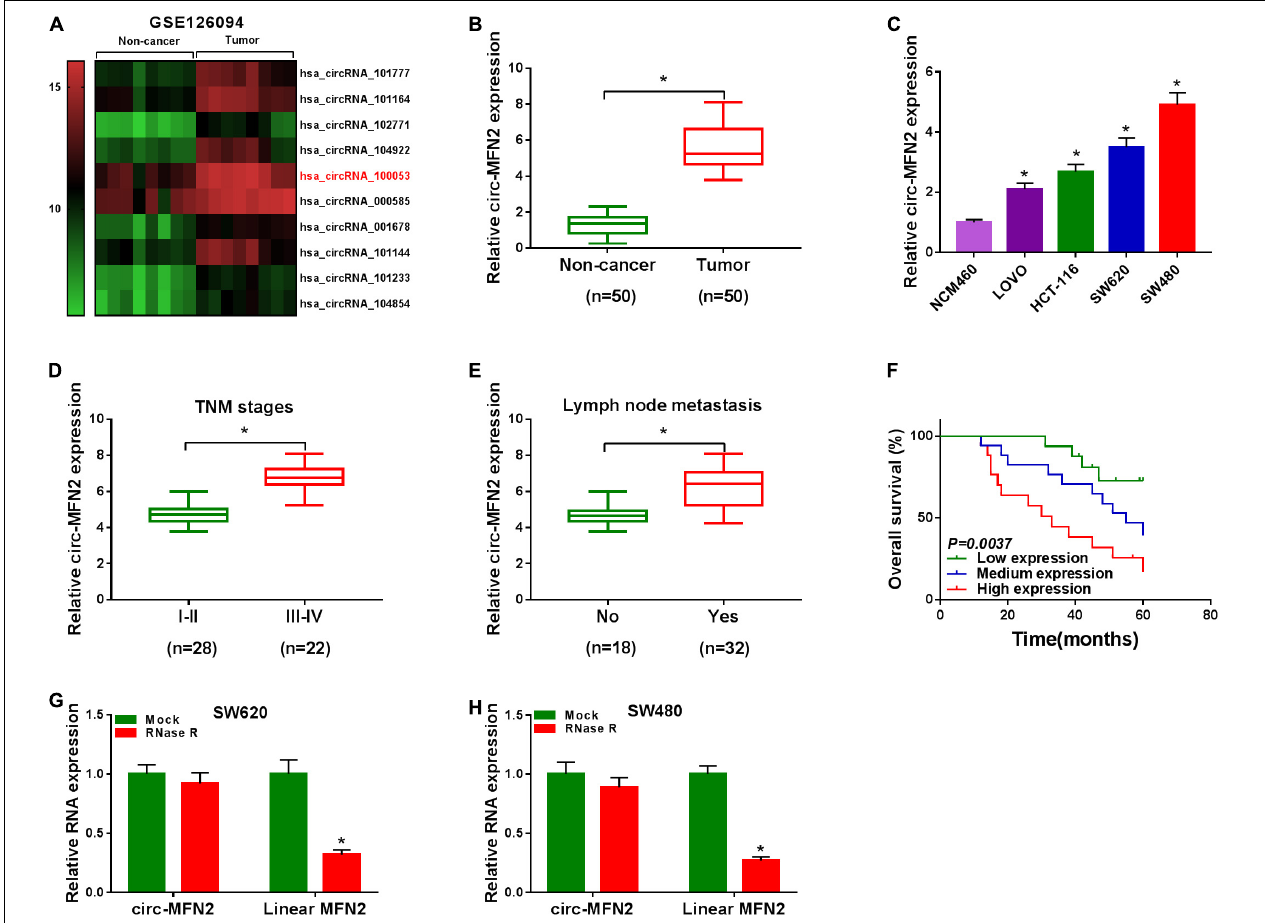
FIGURE 1 | The expression of circ-MFN2 in CRC tissues and cells. (A) Heat map revealed that the differentially expressed circRNAs in 8 paired CRC tumor tissues and non-cancer tissues (GEO accession: GSE126094). (B) The expression of circ-MFN2 in CRC tumor tissues and non-cancer tissues was measured using qRT-PCR. (C) QRT-PCR was used to detect the circ-MFN2 expression in CRC cell lines (LOVO, HCT-116, SW620 and SW480) and NCM460 cells. (D) The expression of circ-MFN2 in different TNM stages (I-II and III-IV) of CRC patients was determined using qRT-PCR. (E) The expression of circ-MFN2 was detected by qRT-PCR in CRC patients with (Yes) or without (No) lymph node metastasis. (F) Kaplan-Meier analysis was performed to analyze the relationship between the circ-MFN2 expression and the overall survival rate of CRC patients. (G,H) RNase R assay was used to confirm the circular structure of circ-MFN2 compared to linear MFN2. * P <